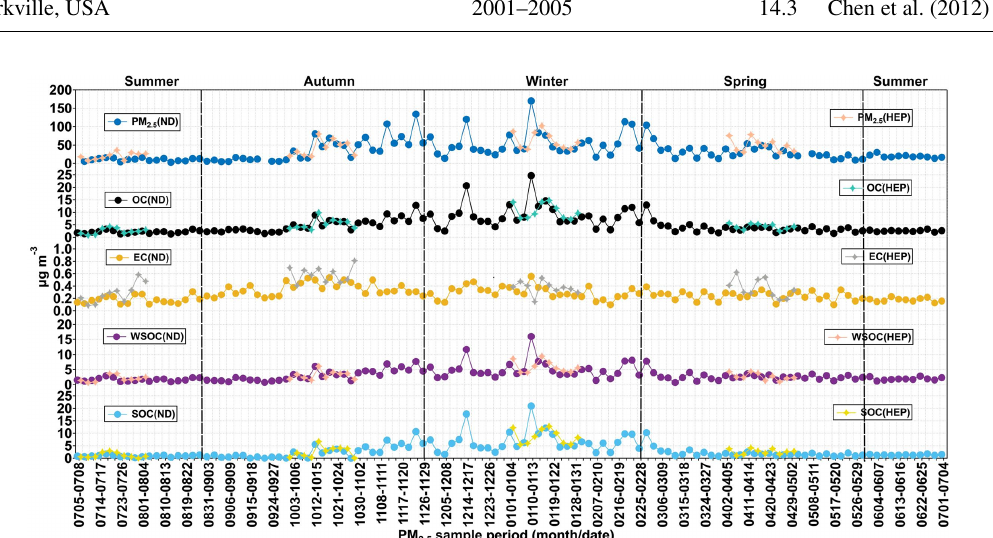
Figure 4. Temporal variations in concentrations (µgm − 3 ) of PM 2 . 5 and its chemical components OC, EC, WSOC and SOC at ND (solid dots) and HEP (solid stars) in Tianjin during 2018–2019. See the text for abbreviations.